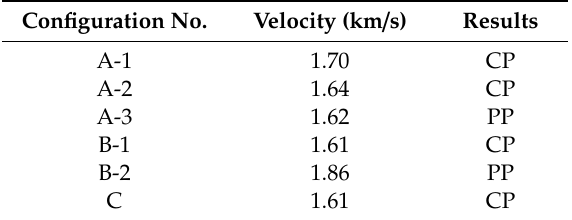
Table 5. The results of the impact tests.